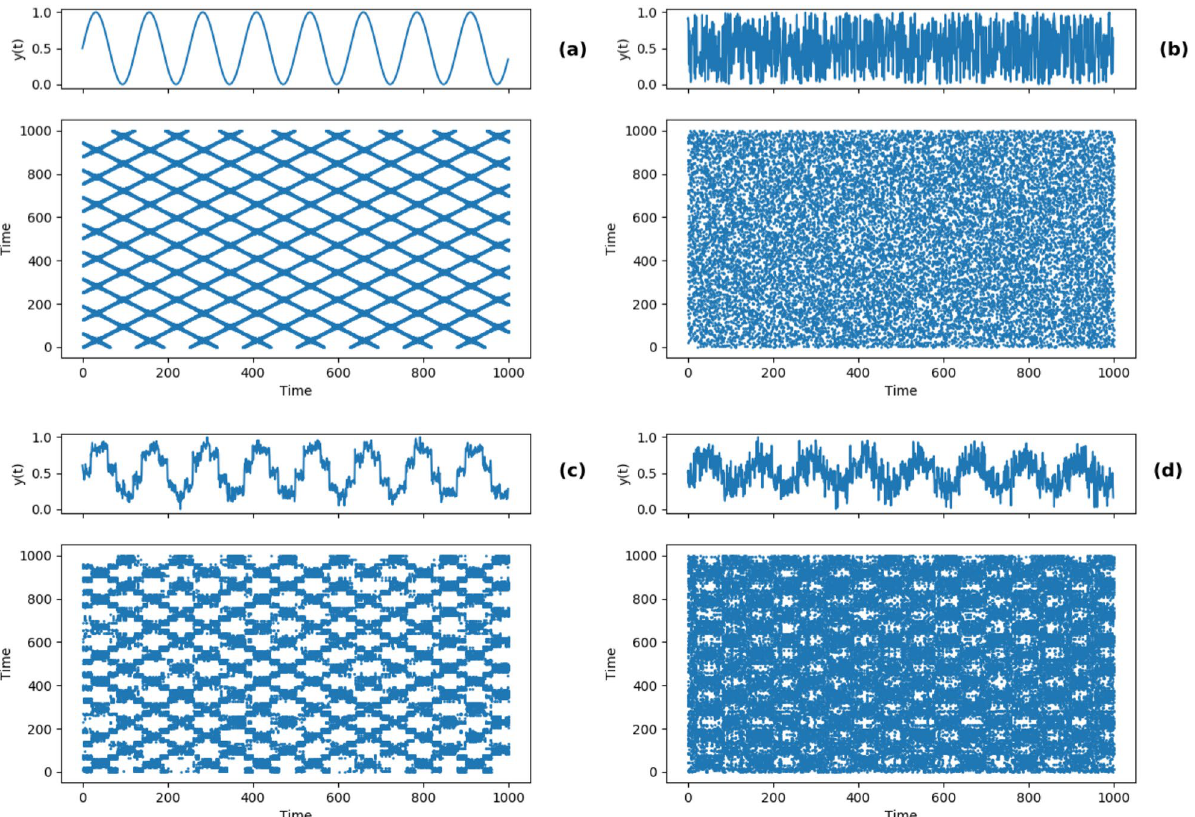
Figure 3. Sample time series and corresponding recurrence plots for ( a ) a pure sine wave ( b ) random noise ( c ) sine wave contaminated with additive white noise with signal to noise ratio (SNR) 5 and ( d ) sine wave contaminated with additive white noise with signal to noise ratio (SNR) 1. A higher SNR implies that the signal is more prominent as compared to the noise.